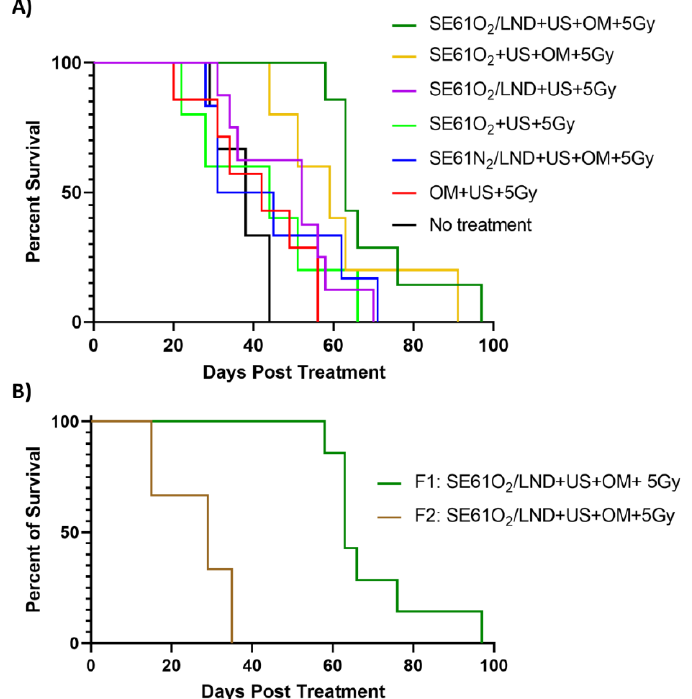
Figure 6. Survival proportion of animals following treatment until day of sacri fi ce. ( A ) Animal survival of all groups; treated groups received radiation with Filter 1 (F1; 3.59 cGy/min). ( B ) A comparison of the experimental group (SE61O 2 /LND) with ultrasound triggering (+ US) and metformin pre-treatment (OM) that received radiation with Filter 1 (dark green plot) and animals treated with the same treatment but that received radiation with Filter 2 (F2; 1.36 cGy/min) (brown plot).